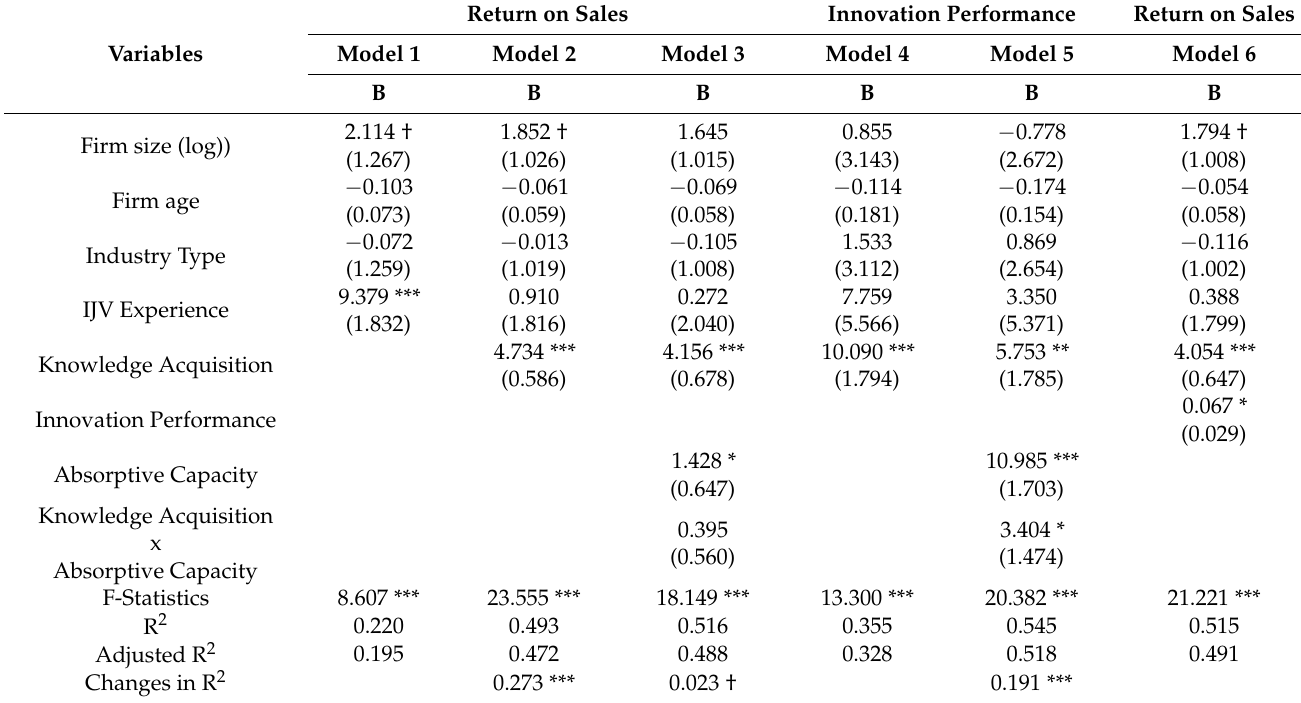
Table A1. Hierarchical multiple regression for return on sales and innovation